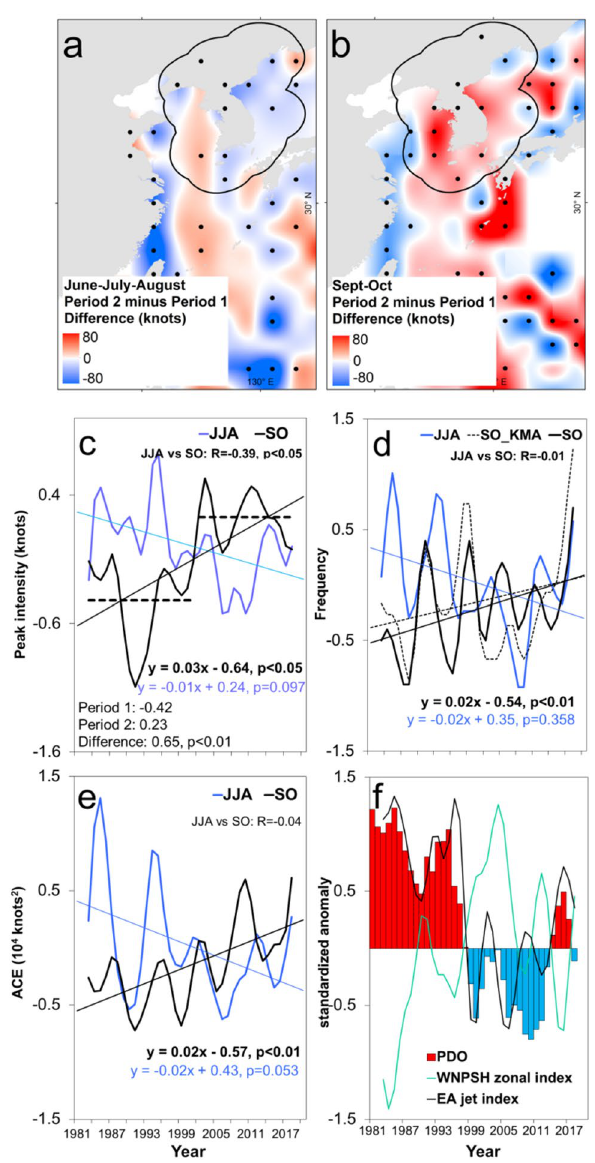
Figure 3. Trend and variability of tropical cyclone (TC) characteristics in the Korean Peninsula (KP). ( a ), ( b ) Composite difference map in the peak TC intensity gridded into 2° × 2° horizontal resolution between Period 1 (1981–2002) and Period 2 (2003–2020) in June–August (JJA) and September–October (SO), respectively. The dots indicate significance at p < 0.05. The black contour line indicates the 250 km buffer zone away from the KP. ( c ) Timeseries of peak TC intensity in JJA (blue) and SO (black), respectively. The dashed lines indicate the mean values of peak TC intensity during Period 1 and Period 2, respectively. The inset statistics show the mean values of peak TC intensity during Period 1 (1981–2002) and Period 2 (2003–2020), and their difference, respectively. ( d ), ( e ) Timeseries of TC frequency and Accumulated Cyclone Energy (ACE) in June–August (blue) and September–October (black), respectively. In d, the dashed line indicates the timeseries of TC frequency during SO from 1981 to 2020 based on KMA data. ( f ) Timeseries of the Pacific Decadal Oscillation (PDO, bar), East Asian subtropical jet stream index (black), and the Western North Pacific subtropical high zonal index (green), respectively. In ( a ), ( b ), the maps are plotted using ArcGIS 10.1 (https:// www. esri.